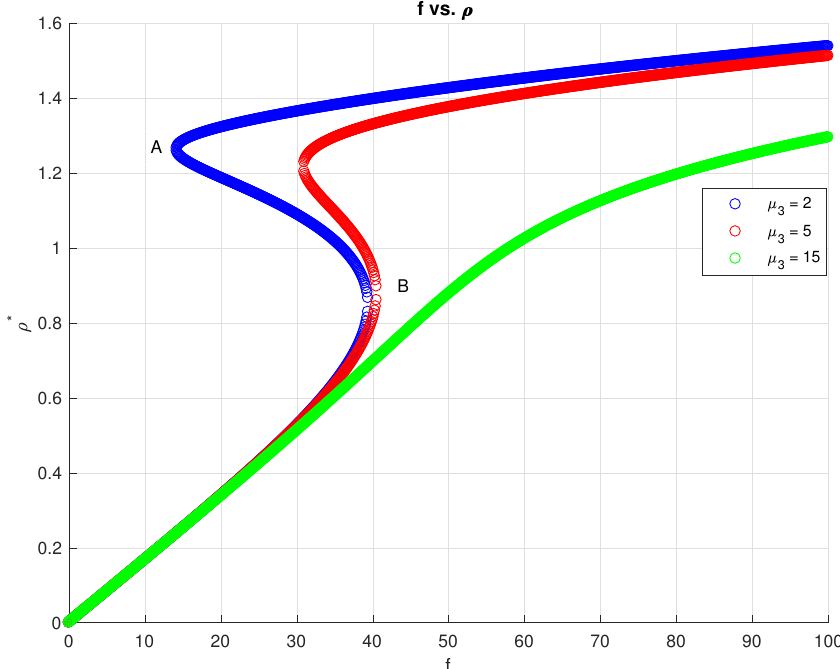
Figure 2. External Excitation Response Curve ( µ 3 = 2,5,15 and µ 1 = 0.4, α 1 = 0.2, α 3 = 1.5, α 5 = 2, σ = 30, k = 1 and m 21 =